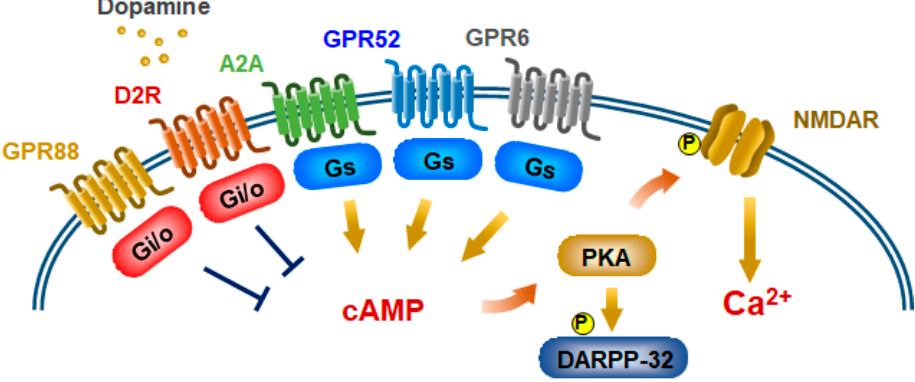
Figure 2. Model of GPCR-mediated NMDA receptor pathways in striatopallidal MSNs. Gs-coupled GPCRs potentiate NMDA receptor activity through phosphorylation of its receptor via cAMP / PKA. Gs-coupled GPR6, GPR52, and A2a receptors, and Gi / o-coupled GPR88 are expressed in striatopallidal MSNs. Activated Gi / o-coupled D2R and GPR88 inhibit NMDA receptor activity through inhibition of cAMP / PKA